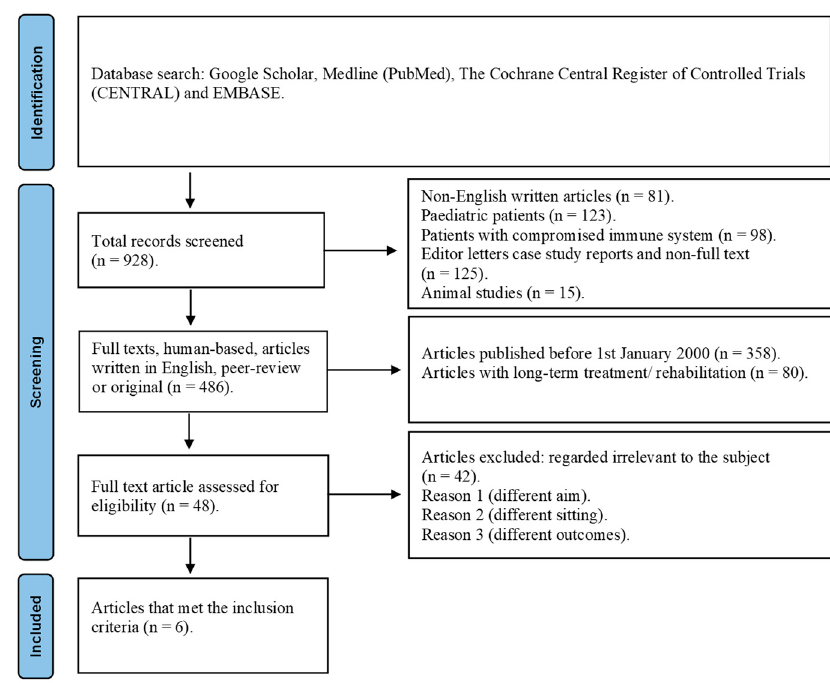
Figure 1. PRISMA flow chart of the screening process.